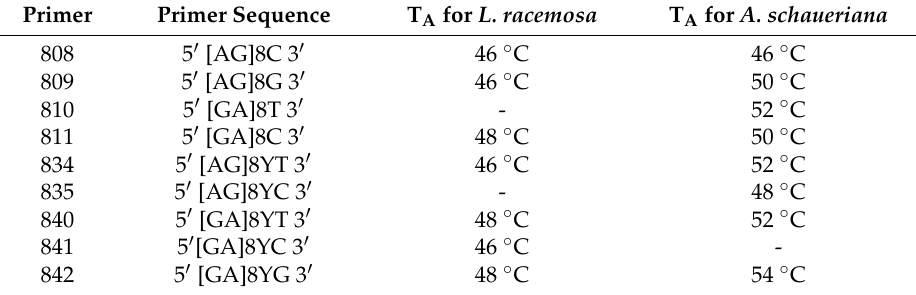
Table 1. Inter-simple sequence repeat (ISSR) primers used for the mangrove populations in the PCR reactions, with their sequences and their annealing temperature (T A ) for each specie, Laguncularia racemosa and Avicennia schaueriana . No annealing temperature means that primer did not amplify for that species. Primer Primer Sequence T A for L.